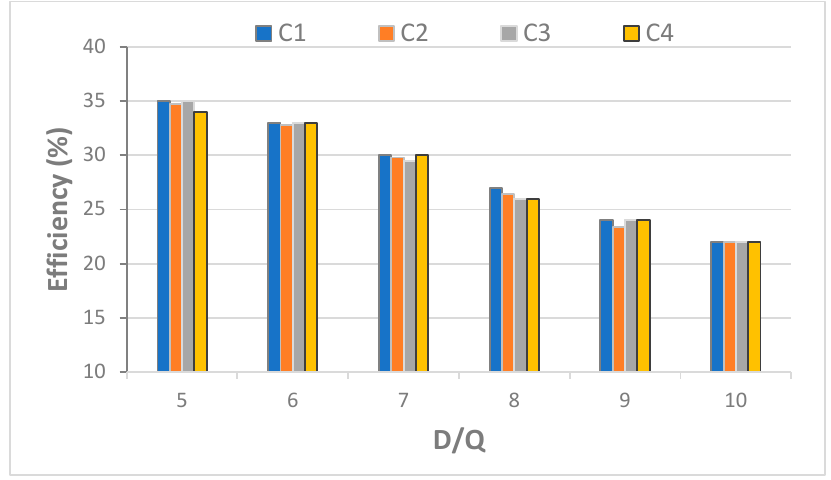
Figure 5. Water saving efficiency dealings with runoff coefficients vs. demand fraction (D/Q).